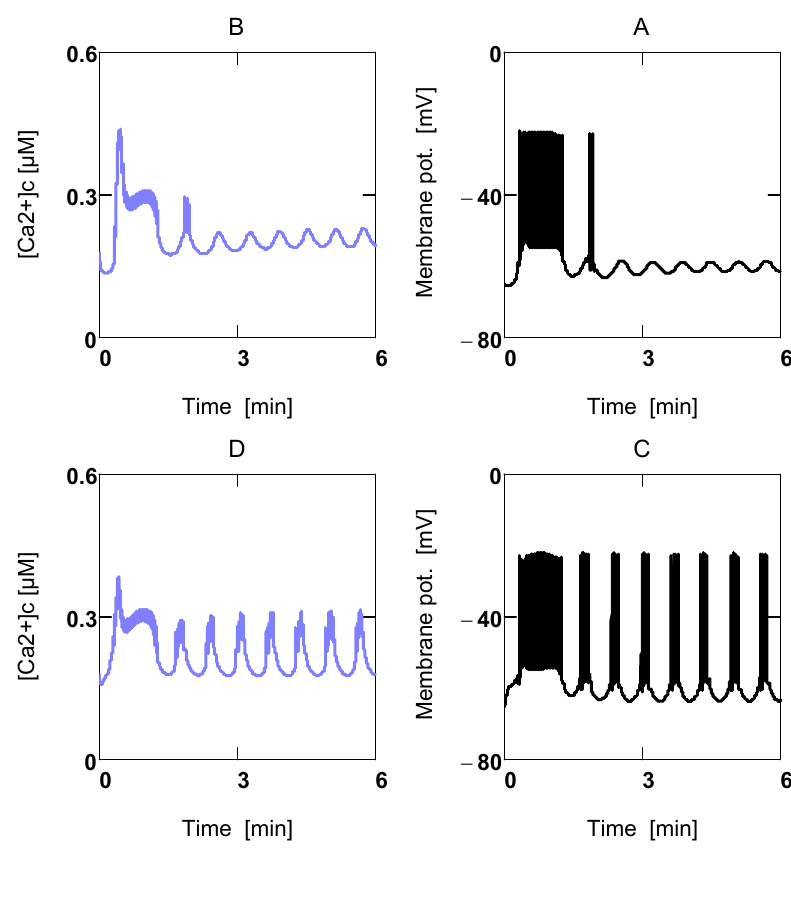
Figure 10. Effect of the PCr system in β -cells.  ( B and D ) in the  ( A and C ) and [Ca 2+ ] c c presence of the PCr system, [Cr ] = 2.0 mM ( A and B) , [Cr ] = 0,5 mM ( C and D )). tot tot Fluxes J and J (A10 and A11) are added to a simulation taken from reference AK CPK